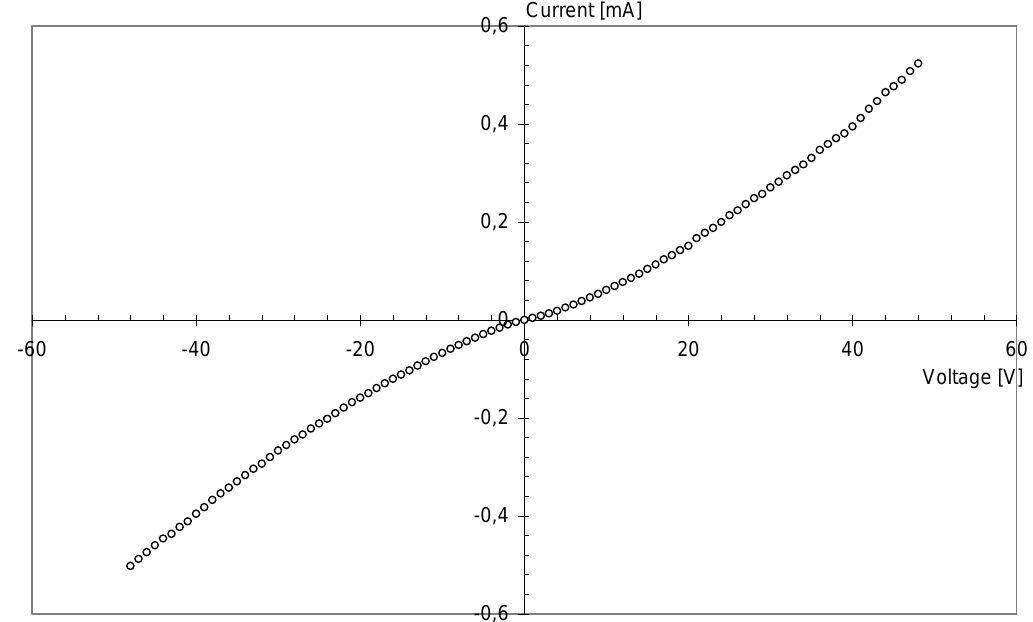
Figure 4. I/V curve for EVO/CB S, CB concentration =7.29 vol.-% ( n = 1.26).